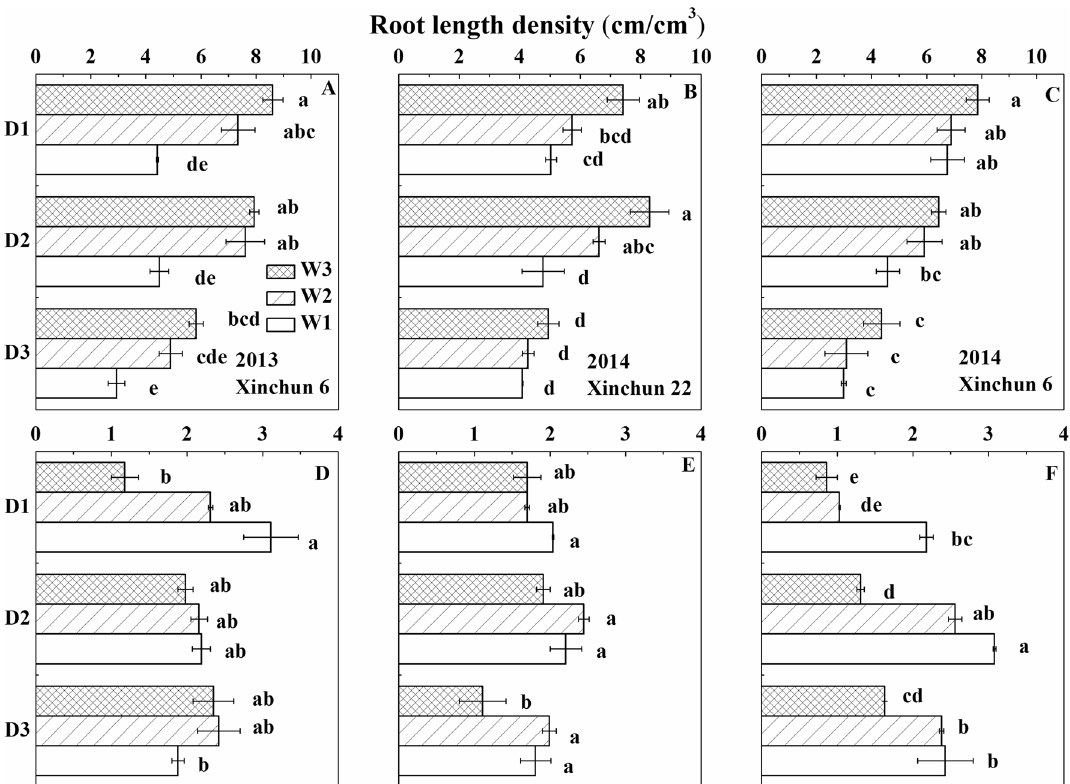
Figure 4. Root length density at flowering as affected by irrigation frequency and amount. ( A ) The root length density of ‘Xinchun 6’ in the 0–20 cm depths in 2013. ( B ) The root length density of ‘Xinchun 22’ in the 0–20 cm depths in 2014. ( C ) The root length density of ‘Xinchun 6’ in the 0–20 cm depths in 2014. ( D ) The root length density of ‘Xinchun 6’ in the 20–40 cm depths in 2013. ( E ) The root length density of ‘Xinchun 22’ in the 20–40 cm depths in 2014. ( F ) The root length density of ‘Xinchun 6’ in the 20–40 cm depths in 2014. Error bars represent ± SE (n = 10). Bars within a panel with a different letter are significantly different at P < greatest in the D3W3 treatment and least in the D1W1 treatment. The LAI of Xinchun 6 was 20% greater than that of Xinchun 22. The change of LAI was similar with leaf Pn. The SLA of Xinchun 6 was significantly affected by irrigation frequency in 2013 but not in 2014. In 2013, the SLA in the D1 plots was 22.1% greater than that in the D2 plots and 24.5% greater than that in the D3 plots. The irrigation amount and interaction effects on the SLA of Xinchun 6 were not significant in either year. Irrigation frequency, irrigation amount, and their interaction had significant effects on the SLA of Xinchun 22. The SLA in the D3 plots was 10.5% greater than that in the D2 plots and 31.9% greater than that in the D1 plots. The SLA decreased in the order W3 > W2 > W1, with that in W3 being 32.6% greater than that in W2 and 22.0% greater than that in W1.